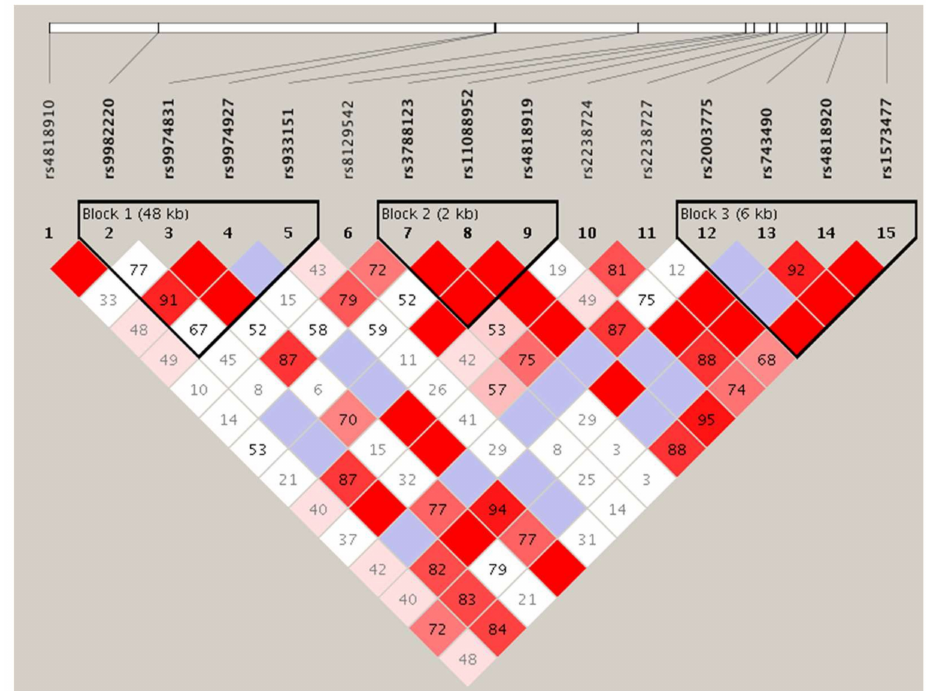
Figure 2. Linkage disequilibrium plot of SNPs of TRPM2 in the samples examined. Numbers in squares indicate D (cid:48) values. The blocks are defined following the four-gamete rule [75] Explanation of